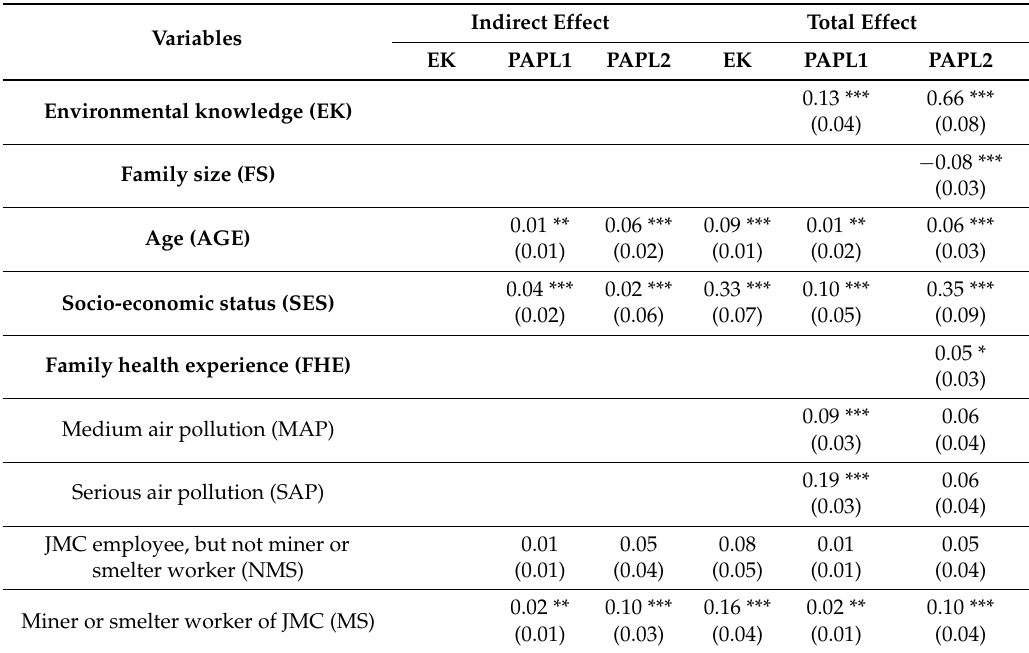
Table 5. Standardized total and indirect effects (Final